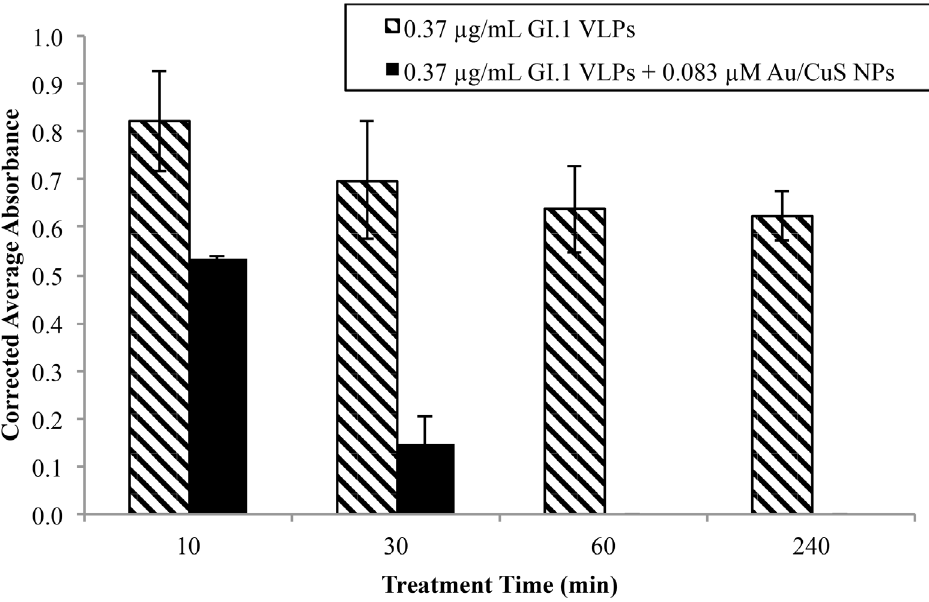
Fig 2. Effect of treatment time on absorbance for VLP solutions treated with 0.83 μ M Au/CuS NP. Absorbance was measured using the three-hour ELISA, and new VLP and NP solutions were prepared for each time point. Reduced absorbance suggests structural damage to the capsid surface proteins and is indicative of VLP